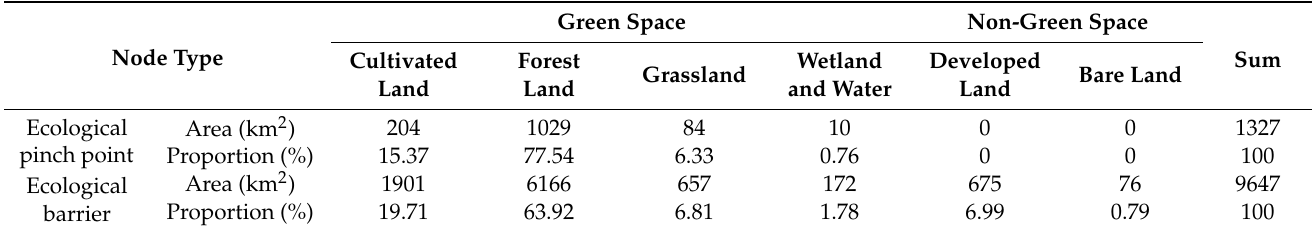
Table 5. Area proportion of types of green spaces in the ecological nodes of